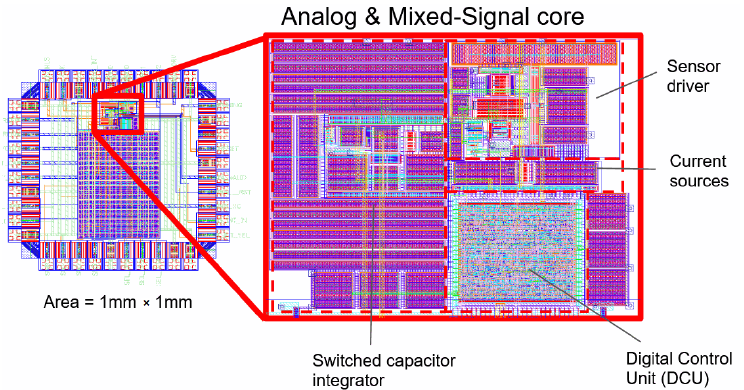
Figure 17. Chip layout.